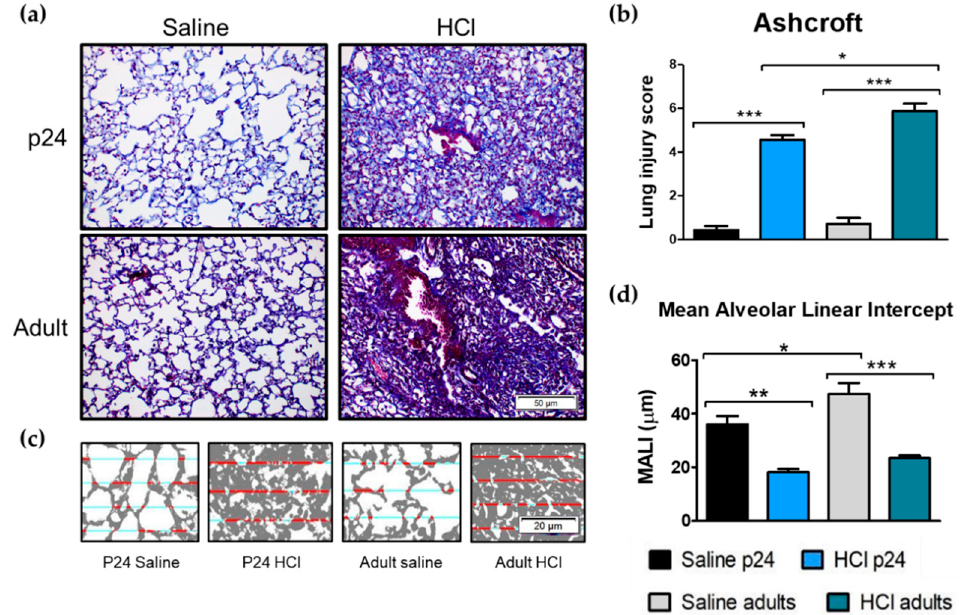
Figure 5. Age-related differences in pulmonary fibrosis, Ashcroft score, and Mean Alveolar Linear Intercept (MALI) 30 days after intratracheal instillation of saline or HCl in young p24 and adult mice. ( a ) Adult mice instilled with HCl display a significant loss of parenchymal architecture compared with the adult controls. Young p24 mice similarly display a fibrotic process with the formation of collagen fibers, but with the maintenance of alveoli and parenchymal structures. Original magnification 20 × , scale bars 50 µ M. ( b ) Adult mice exhibit higher Ashcroft scores compared with young mice after HCl instillation. ( c , d ) MALI is reduced in both young and adult mice. Original magnification 40 × , scale bars 20 µ M. Means ± SEM, n = 3–5, * p < 0.05; ** p < 0.01, ***: p < 0.001 with one-way ANOVA and Tukey’s